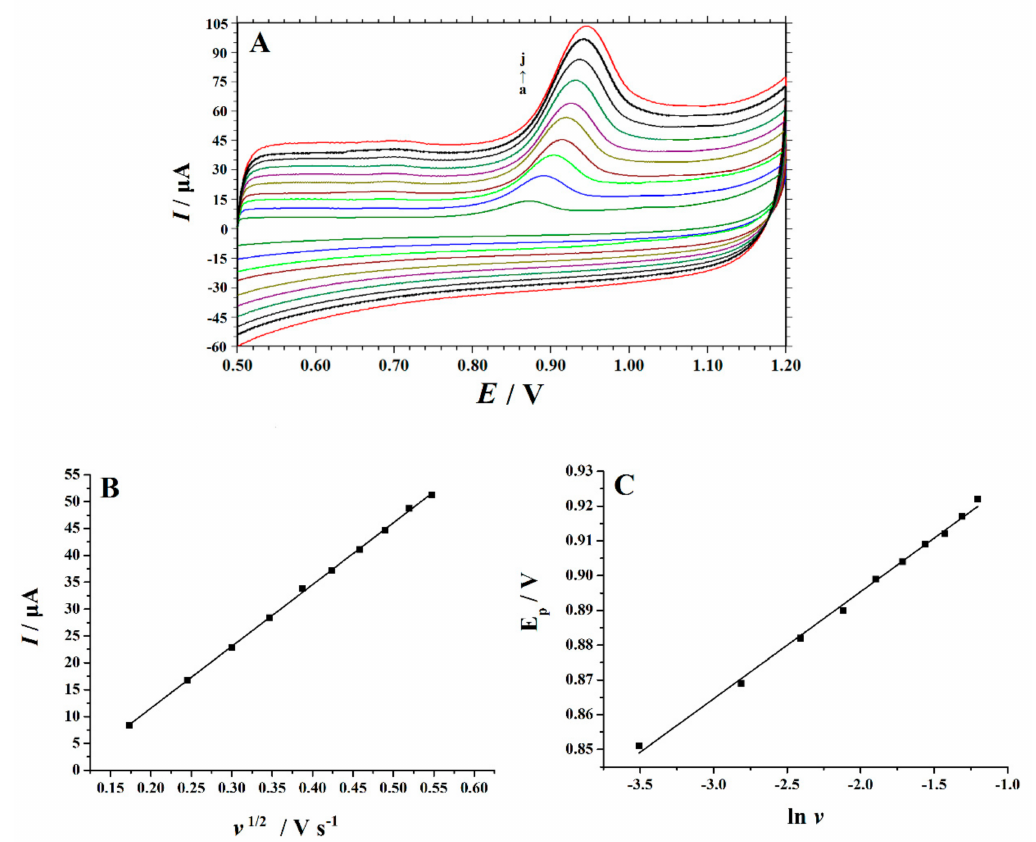
Figure 4. ( A ) CVs of 10 µ M Trp at the PVP-GR / GCE in 0.1 M phosphate bu ff er solution (PBS) (pH 2.2) with di ff erent scan rates. a–g were 0.03, 0.06, 0.09, 0.12, 0.15, 0.18, 0.21, 0.24, 0.27, 0.30 V s − 1 , respectively; ( B ) the plot of oxidation peak currents ( I p ) vs. the square root of scan rates ( v 1 / 2 ); ( C ) the peak potentials ( E p ) vs. the Napierian logarithm of scan rates (ln v